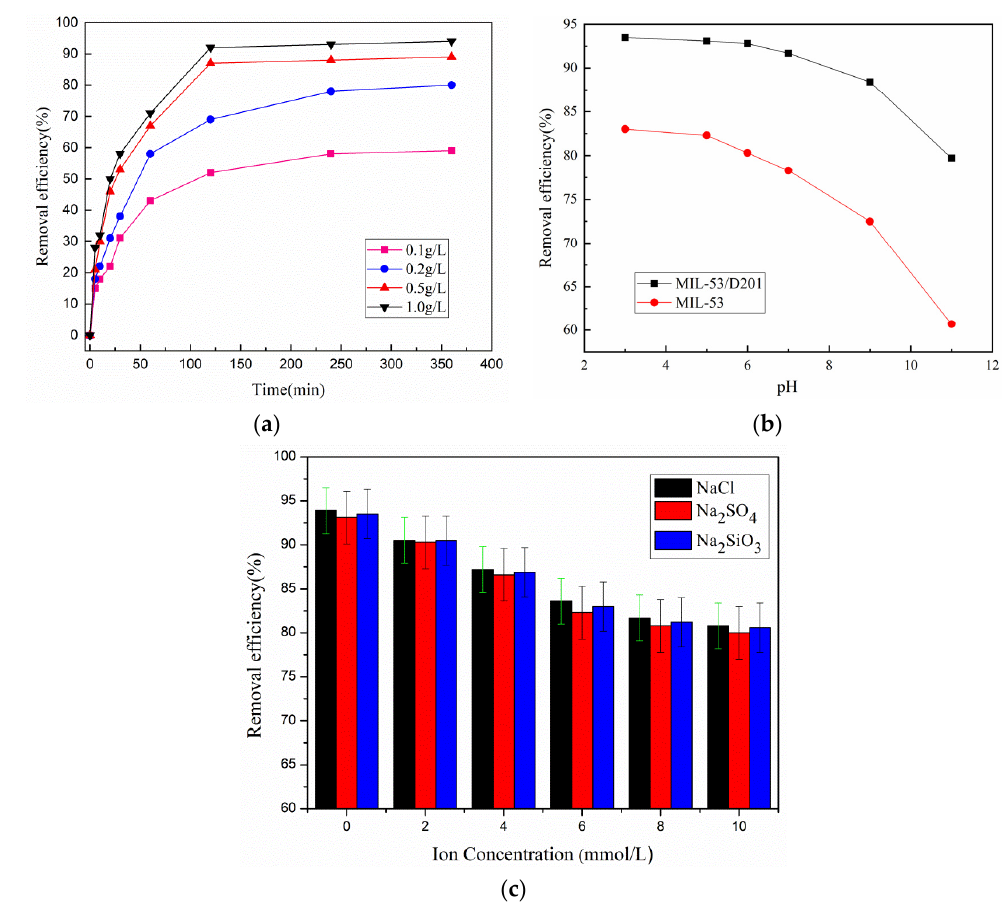
Figure 7. The effect of the addition amount of MIL-53/D201 ( a ), solution pH ( b ), and interfering ions ( c ) on the removal of azlocillin sodium.